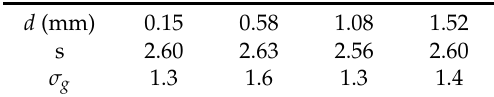
Table 1. Sediment characteristics. d : median diameter, s : relative mass density, σ g : geometric standard deviation of sediment